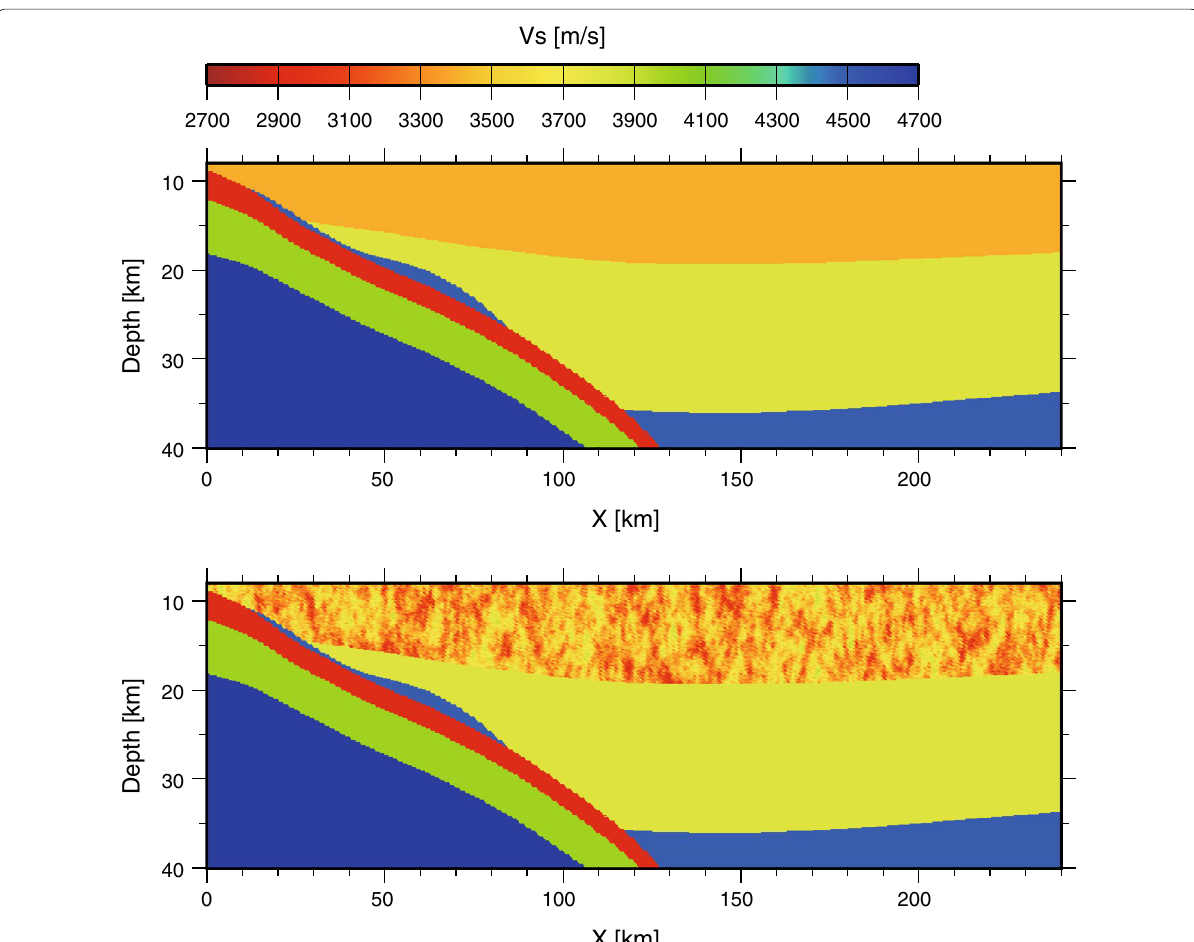
Fig. 2 North–south cross-sectional view of the S-wave velocity for the homogeneous (top) and heterogeneous (bottom) velocity models. See Fig. 1 for the location of the cross section